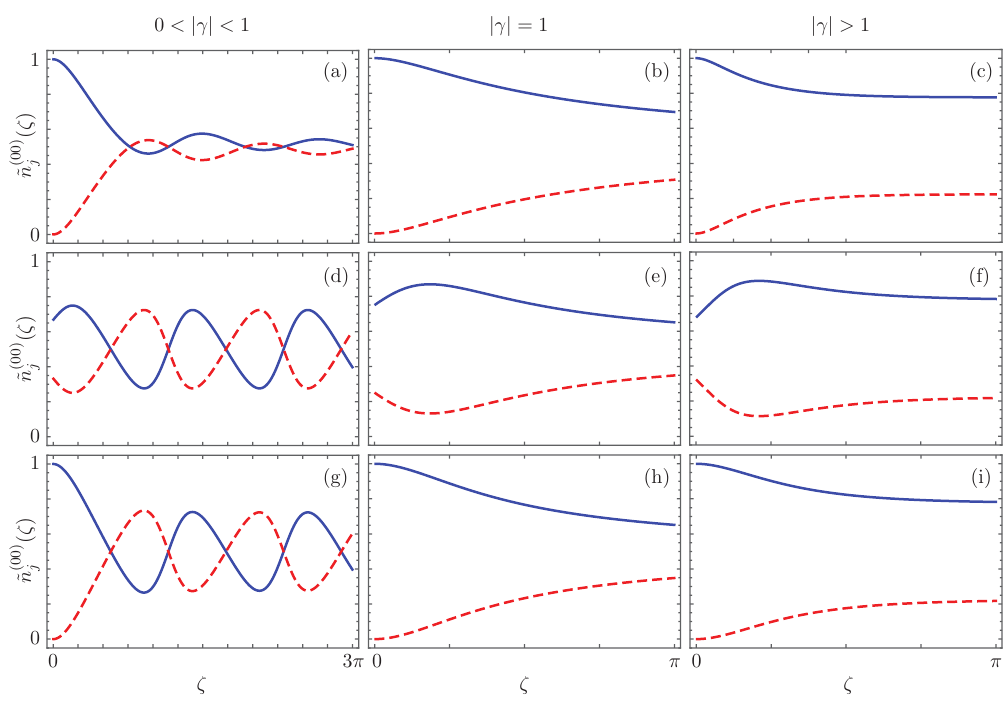
( ζ ) , along different realizations Figure 2. Instantaneously renormalized spontaneous generation, ˜ n ( 00 ) j of the effective -symmetric dimer. The first row, ( a – c ), shows balanced gain-loss, second row, PT ( d – f ), shows gain-gain, and third row, ( g – i ), shows gain-passive configurations in the -symmetric PT = 0.5, the Kato point with = 1, the second column, and broken γ γ regime, the first column with | | | | = 1.2. Values for the first and second waveguides γ symmetry regime, and the third column with | | are shown with a solid blue and a dashed red lines, in that order. Note the oscillatory behavior of the spontaneous generation inside and its asymptotic behavior outside the -symmetric PT